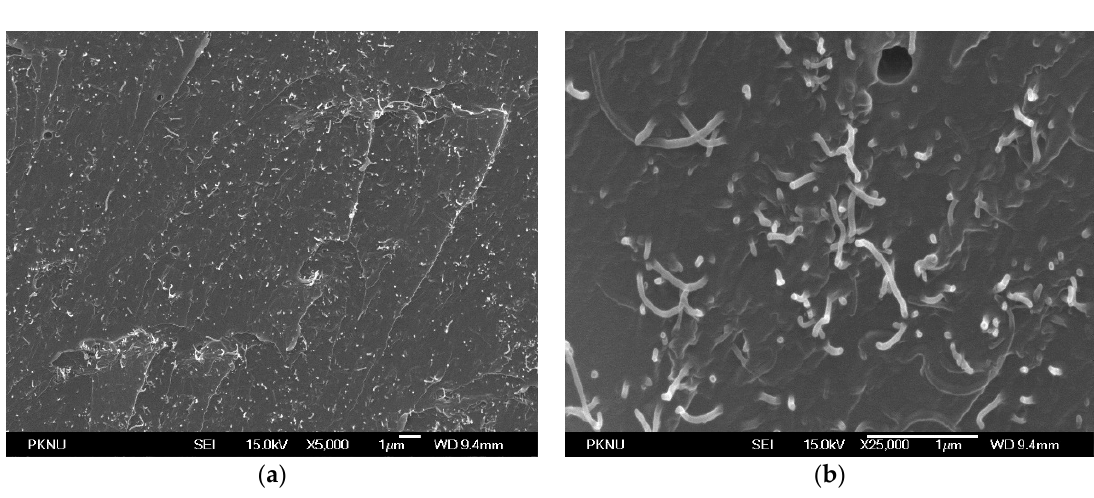
Figure 2. FE-SEM images of sprayed MWCNT/epoxy (3 wt. %) samples: ( a ) 5000× and ( b ) 25,000×.